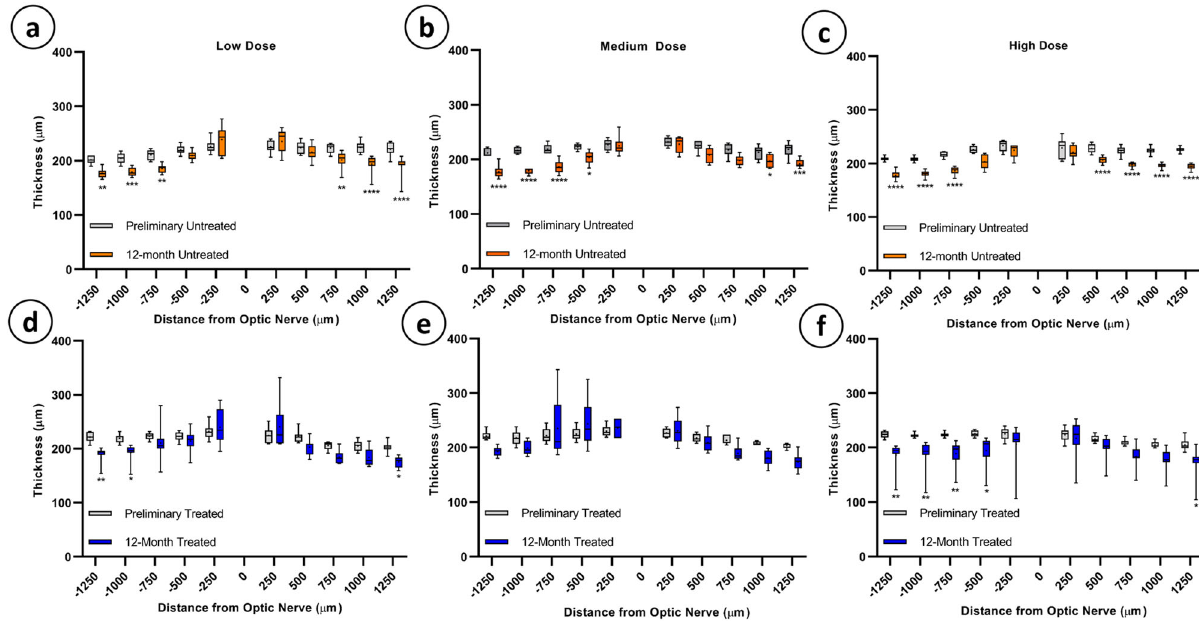
Fig. 3 Total retinal thickness at baseline vs. 12-months as assessed by SD-OCT. Signi fi cant thinning of the retina was observed at various eccentricities from the optic nerve at the 12-month timepoint for both untreated ( a – c ) and treated eyes ( d , f ) as compared to baseline measurements. No signi fi cant thinning was noted in the medium dose treated eyes ( e ). (Two-way ANOVA with post hoc Sidak ’ s multiple comparison test, p = 0.0123-0.0335 (*), 0.0027-0.0087 (**), 0.0007 (***), and <0.0001(****)). Box plot elements: mean = + , centerline = median, box limits = 25th and 75th percentiles, whiskers = min and